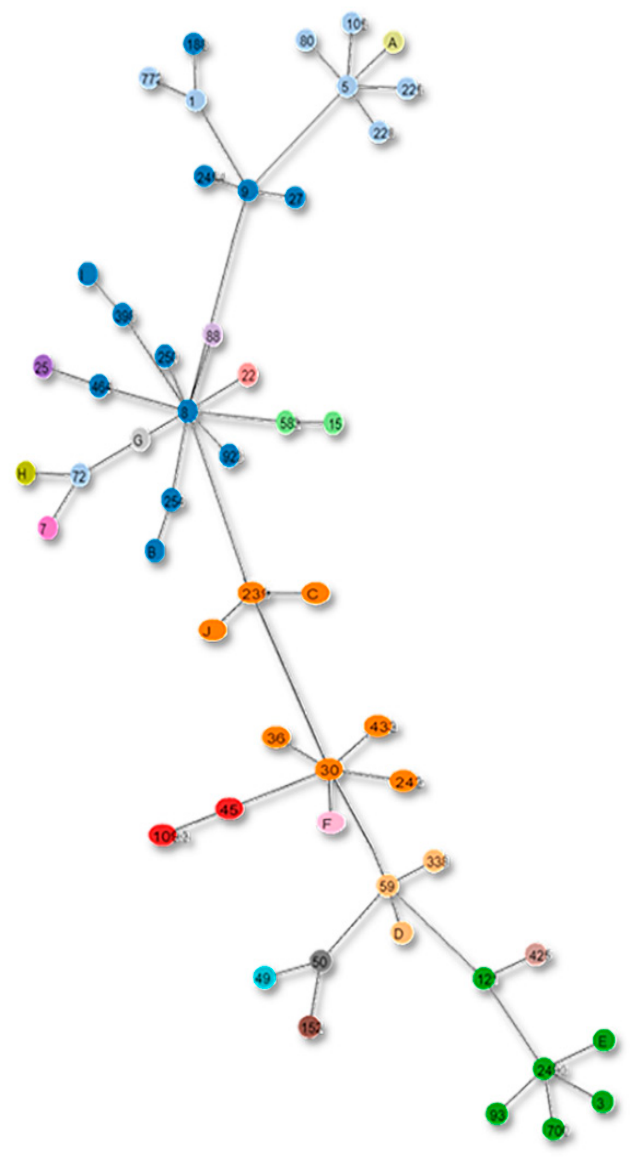
Figure 8. Clonal complexes in the Tree based on the current MLST scheme. The alphabets in the figure show the strains with unreported STs according to the new scheme.